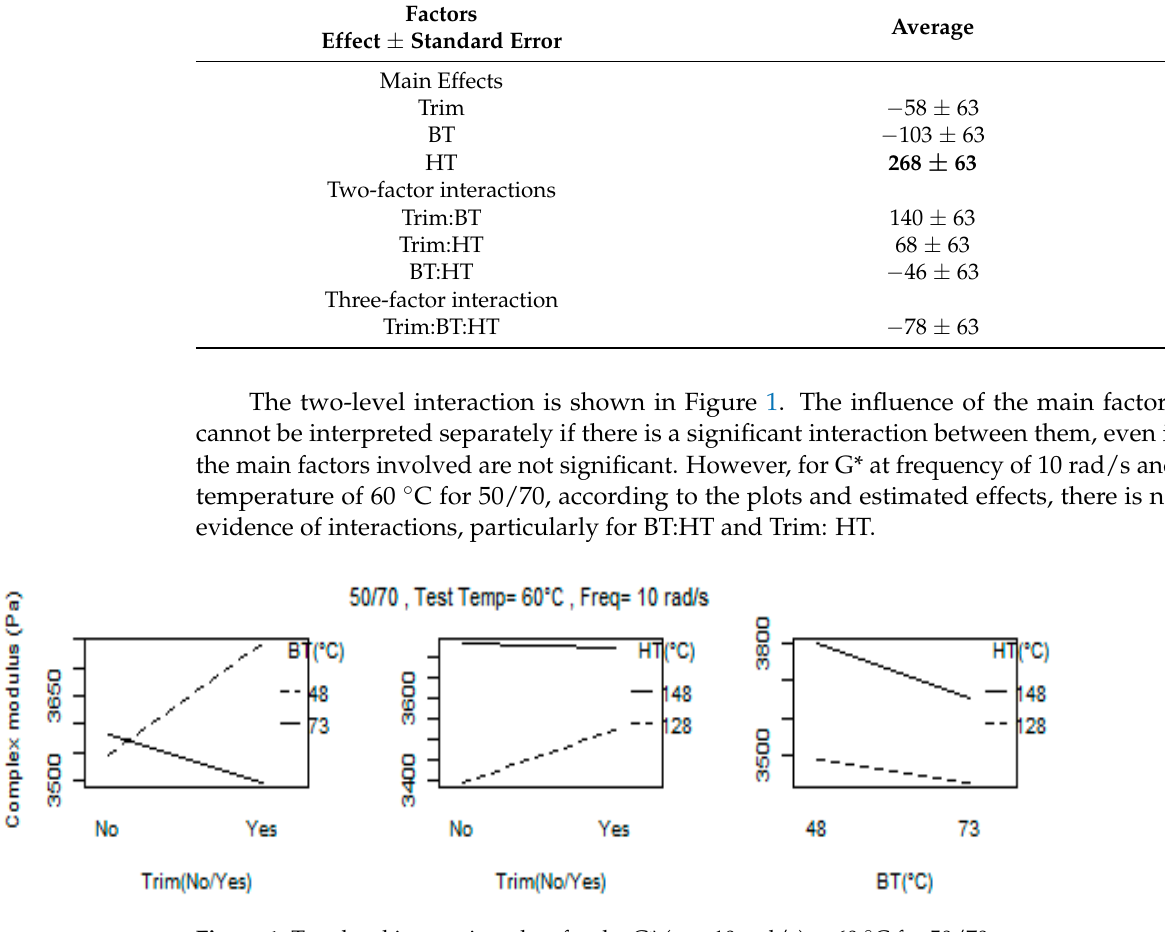
Figure 1. Two-level interaction plots for the G* ( ω = 10 rad/s) at 60 °C for 50/70.